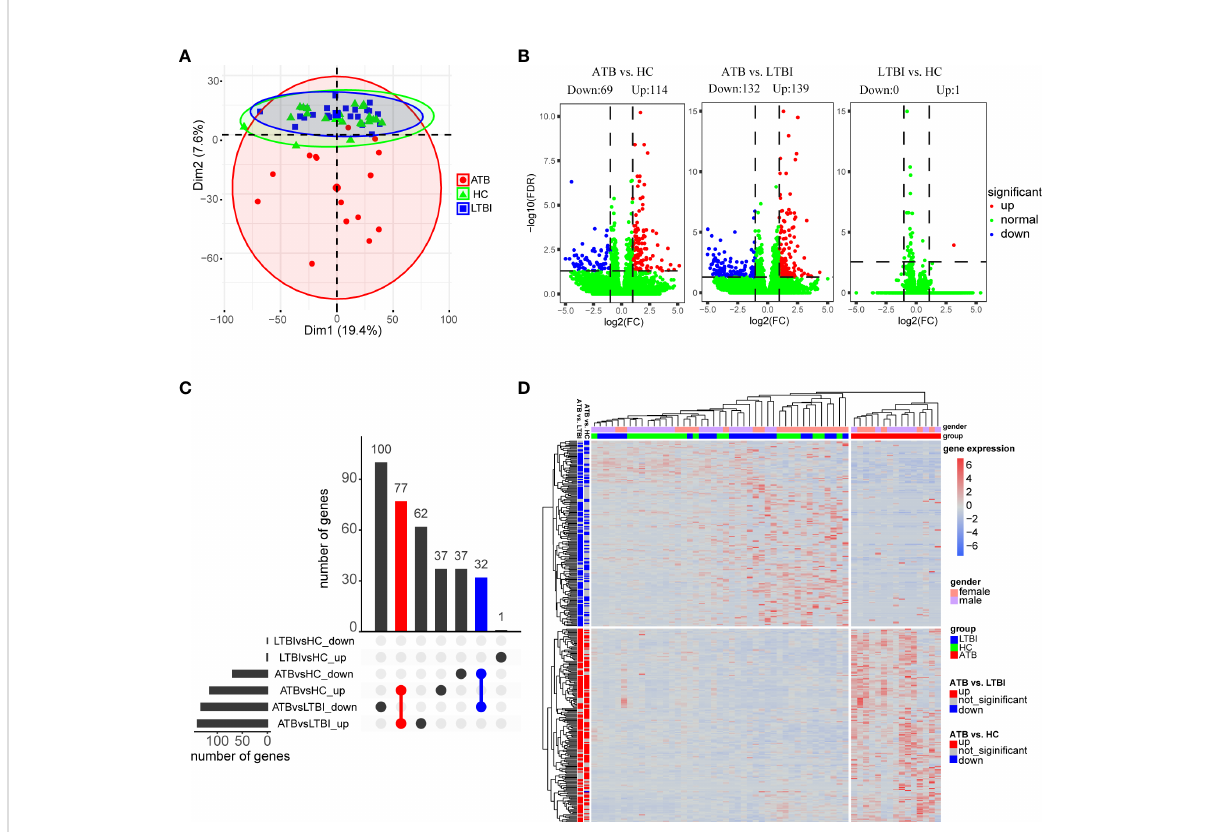
FIGURE 1 Analysis of differential expression of neutrophils in three groups of samples. (A) Principal component analysis of gene expression pro fi les grouped by different tuberculosis infection status. (B) Volcano plot shows the distribution of differentially expressed genes in pairwise comparisons among the three groups of samples. (C) Upset plot shows the overlap of the three sets of differentially expressed genes. (D) Hierarchical clustering heatmap of differentially expressed genes in all samples. Each row represents a gene, columns represent samples, and relative levels of gene expression are represented by color scale, with red for high expression and blue for low